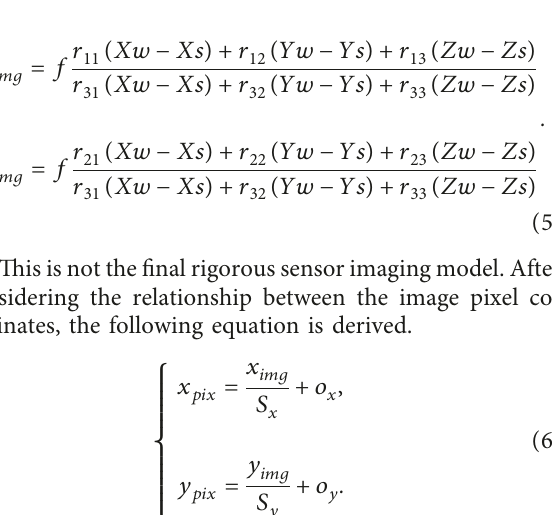
Figure 4: Schematic diagram of the imaging principle of the sensor